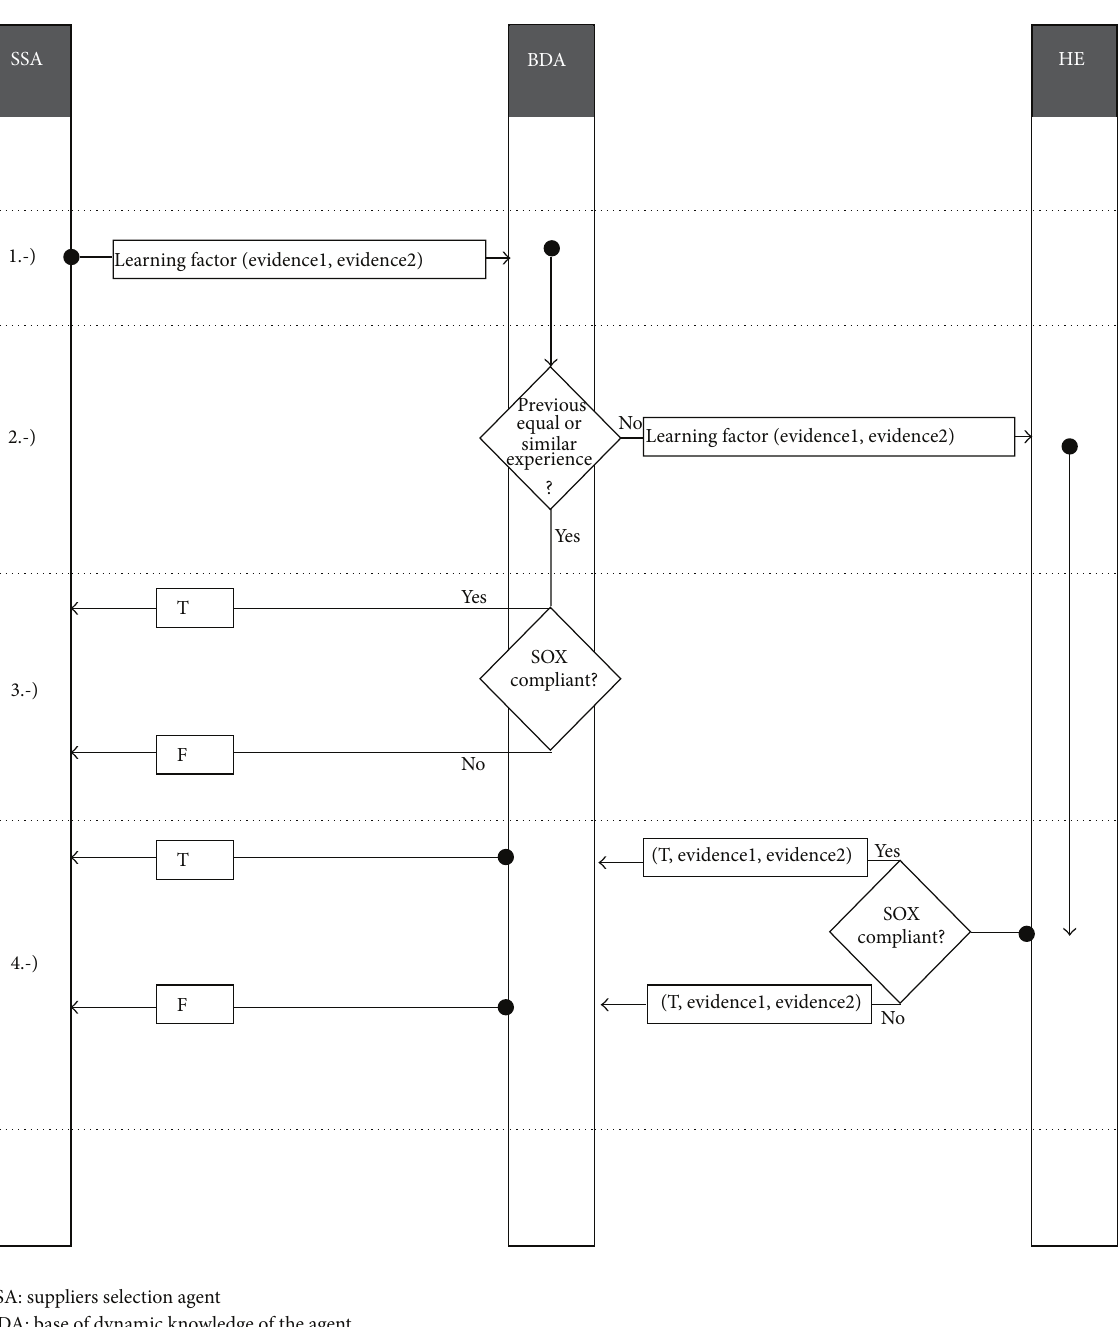
Figure 4: Dynamic Fuzzy Learning